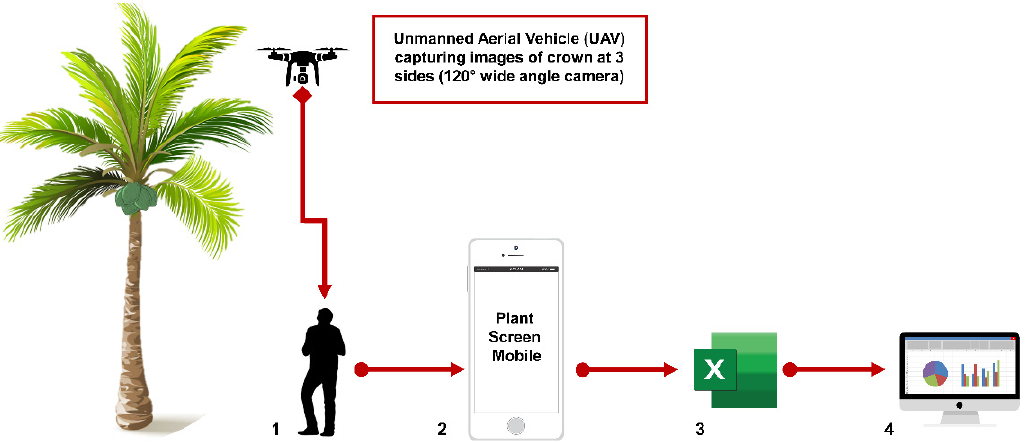
Figure 3. (1) UAV is utilized to capture the image of crown at three sides (for camera with 120 ◦ wide angle). (2) The image is transferred into the Plant Screen Mobile App (PMS) folder. (3) The total leaf area is automatically generated in CSV format. (4) Data analysis with relevant tools to obtain desired observations.